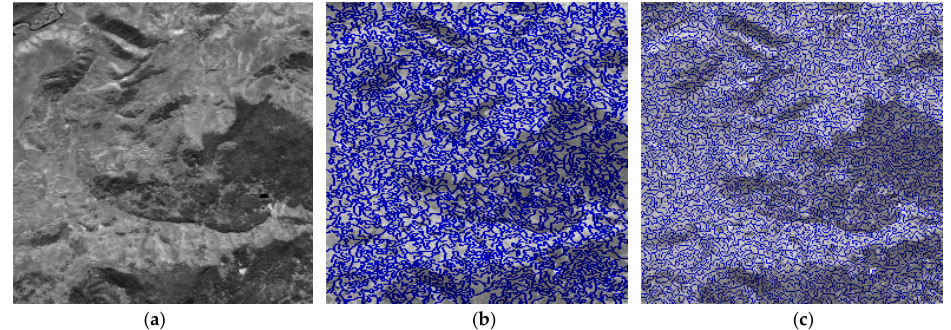
Figure 14. The snapshot of the textured AVIRIS (airborne visible/infrared imaging spectrometer) dataset Yellowstone 0 and its superpixel segmentation, (a) original image (61st band), (b) superpixel segmentation ( K = 500), (c) superpixel segmentation ( K = 2000).